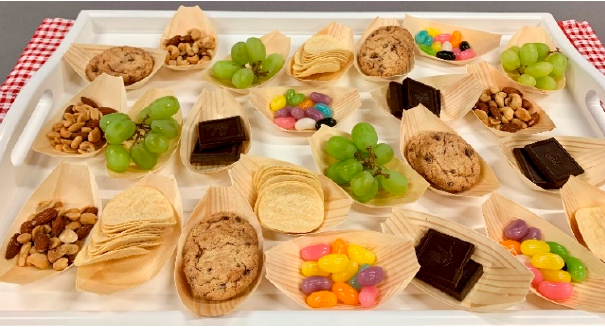
Figure 1. Picture of the six snacks in a randomized display.